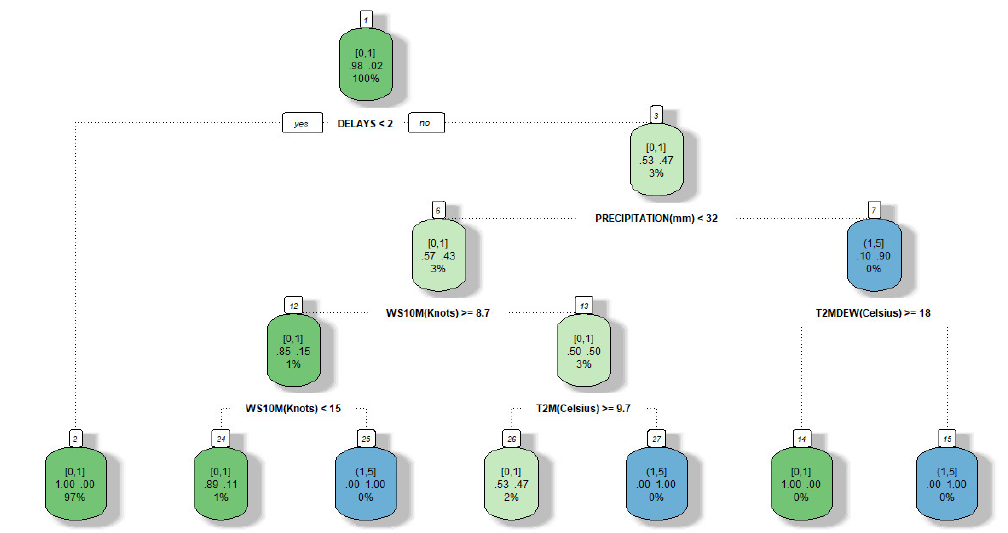
Figure 6. Decision tree predicting the ranges of cancellations within a single day.